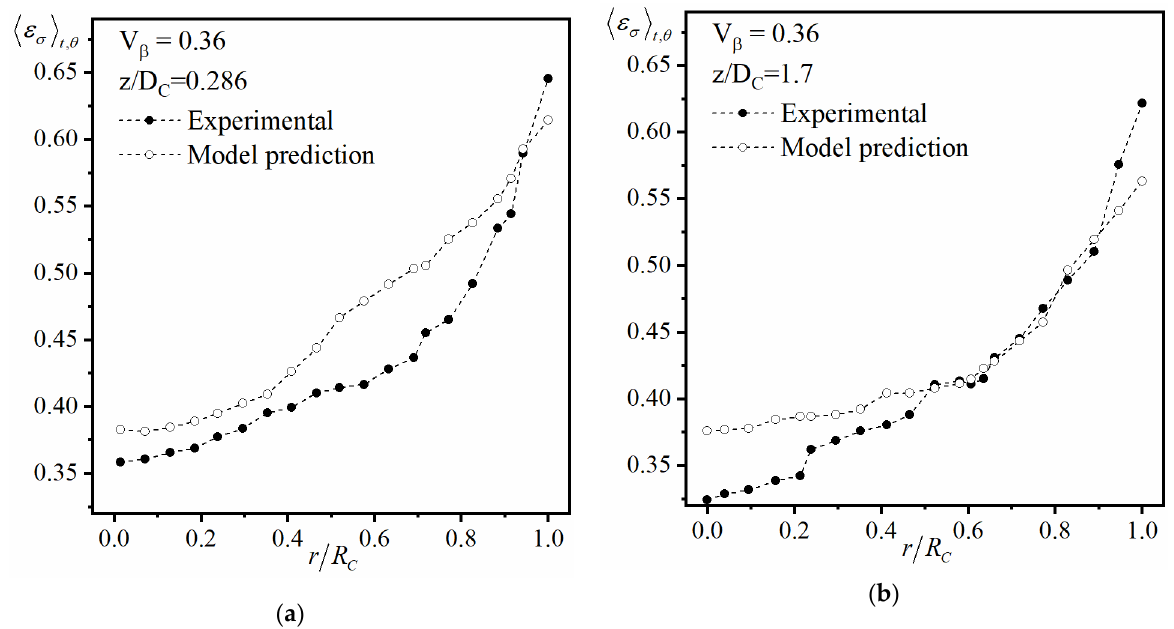
(cid:10) (cid:11) = 0.36 m/s for a fluidized bed of D V β 0